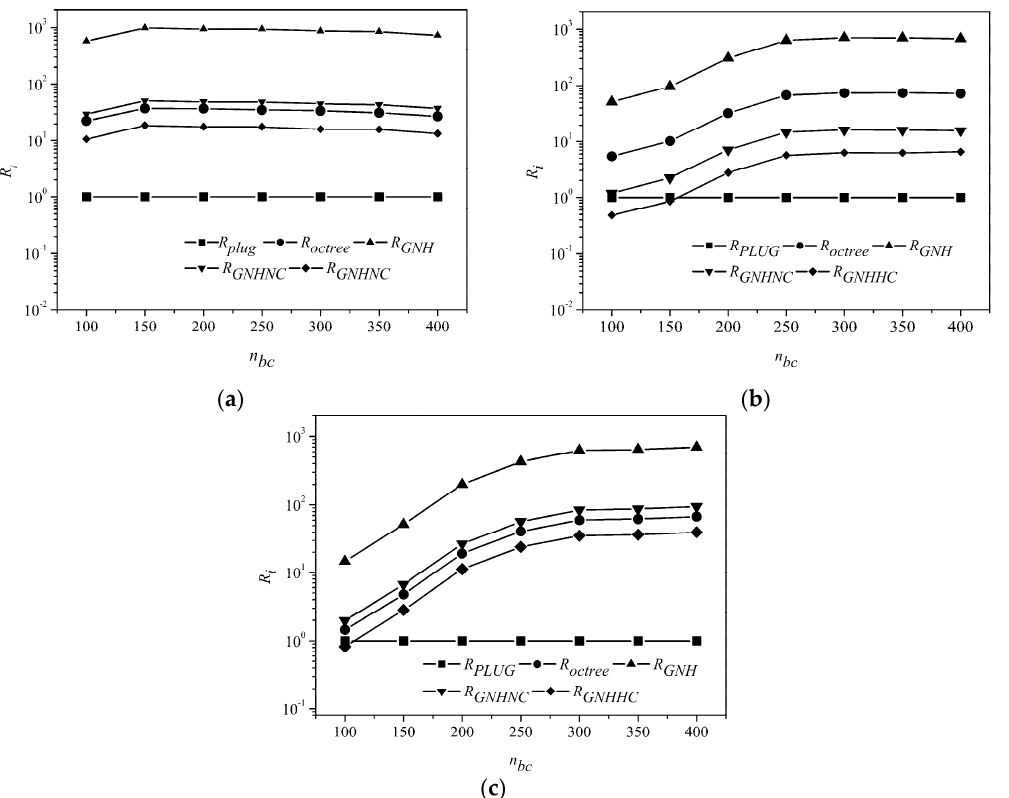
Figure 10. Normalized CPU times. ( a ) Hexahedral mesh; ( b ) Tetrahedral mesh; ( c ) Polyhedral mesh.